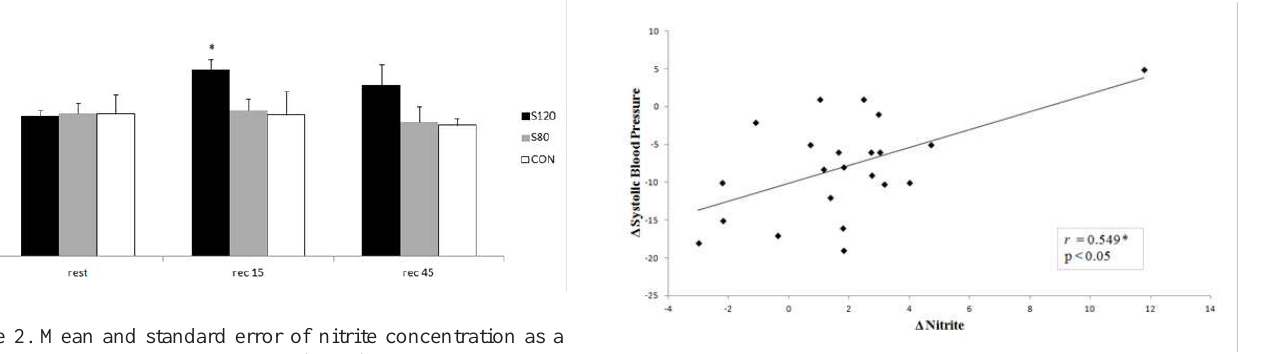
Figure 3. Pearson correlation between Ä systolic blood pressure and Ä nitrite release at exercise session at 120% of lactate threshold